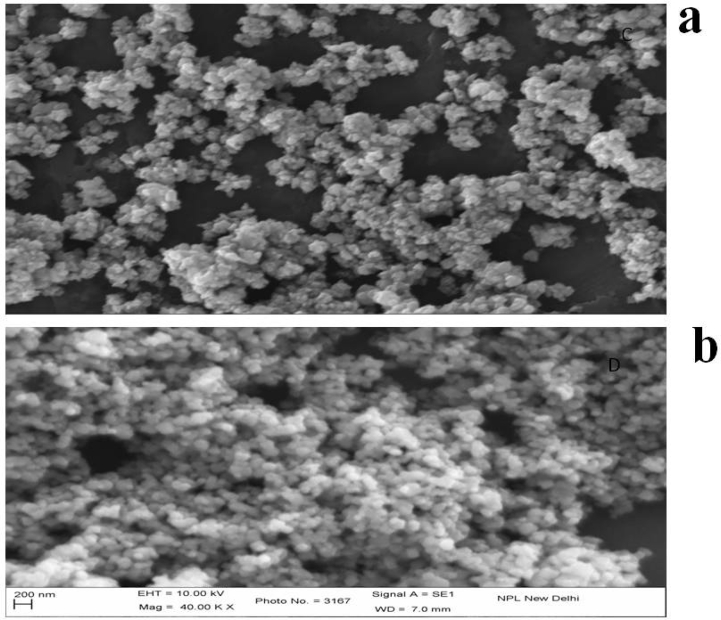
SEM images of synthesized (a) ZnO NPs and (b) TiO2 NPs.